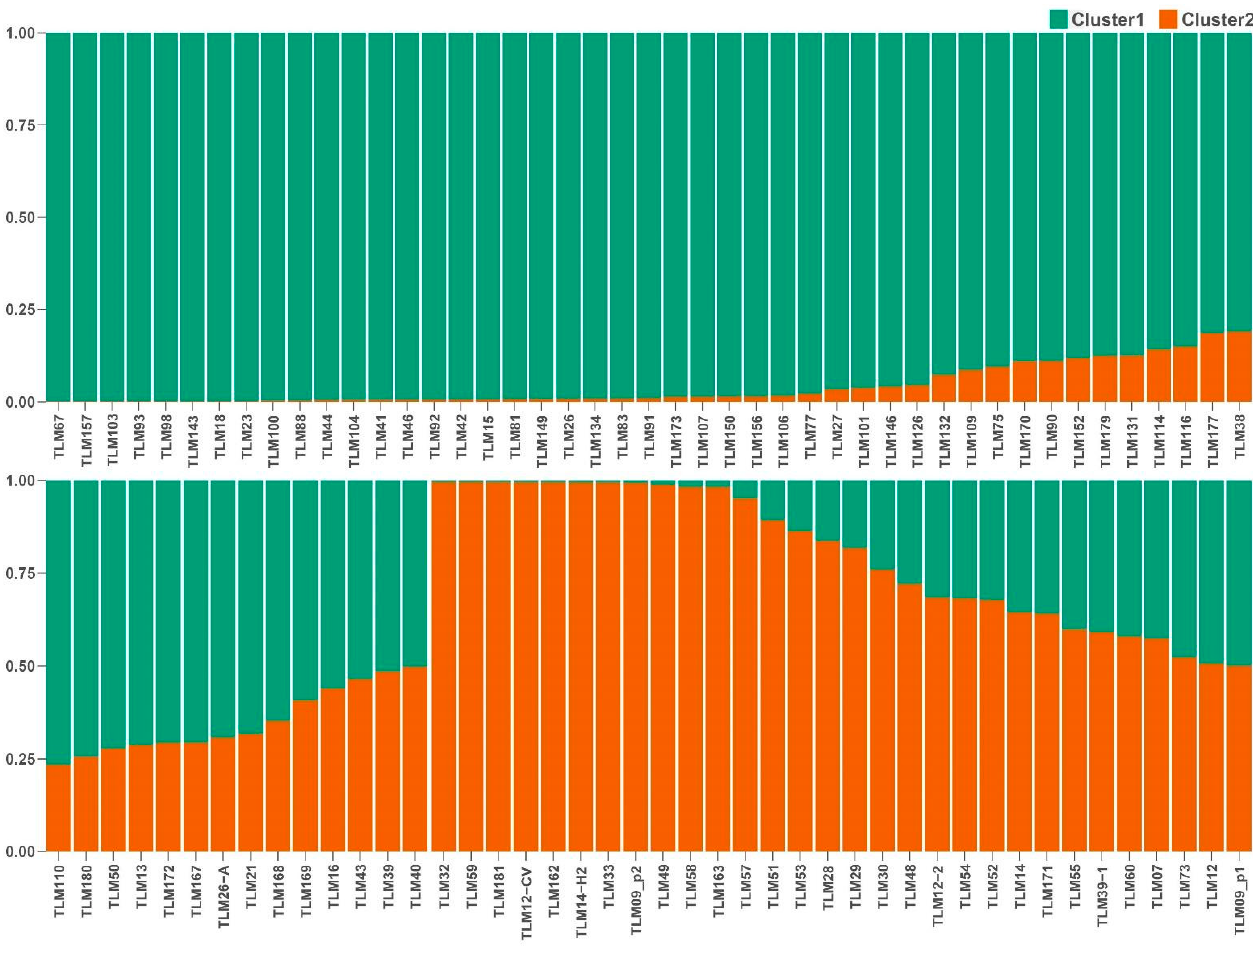
Figure 2. Population structure of 89 samples of tarwi inferred by the STRUCTURE analysis using 5922 SNP markers. Table 2. Origin of the tarwi germplasm collection among the two clusters inferred by the STRUC- TURE analysis.